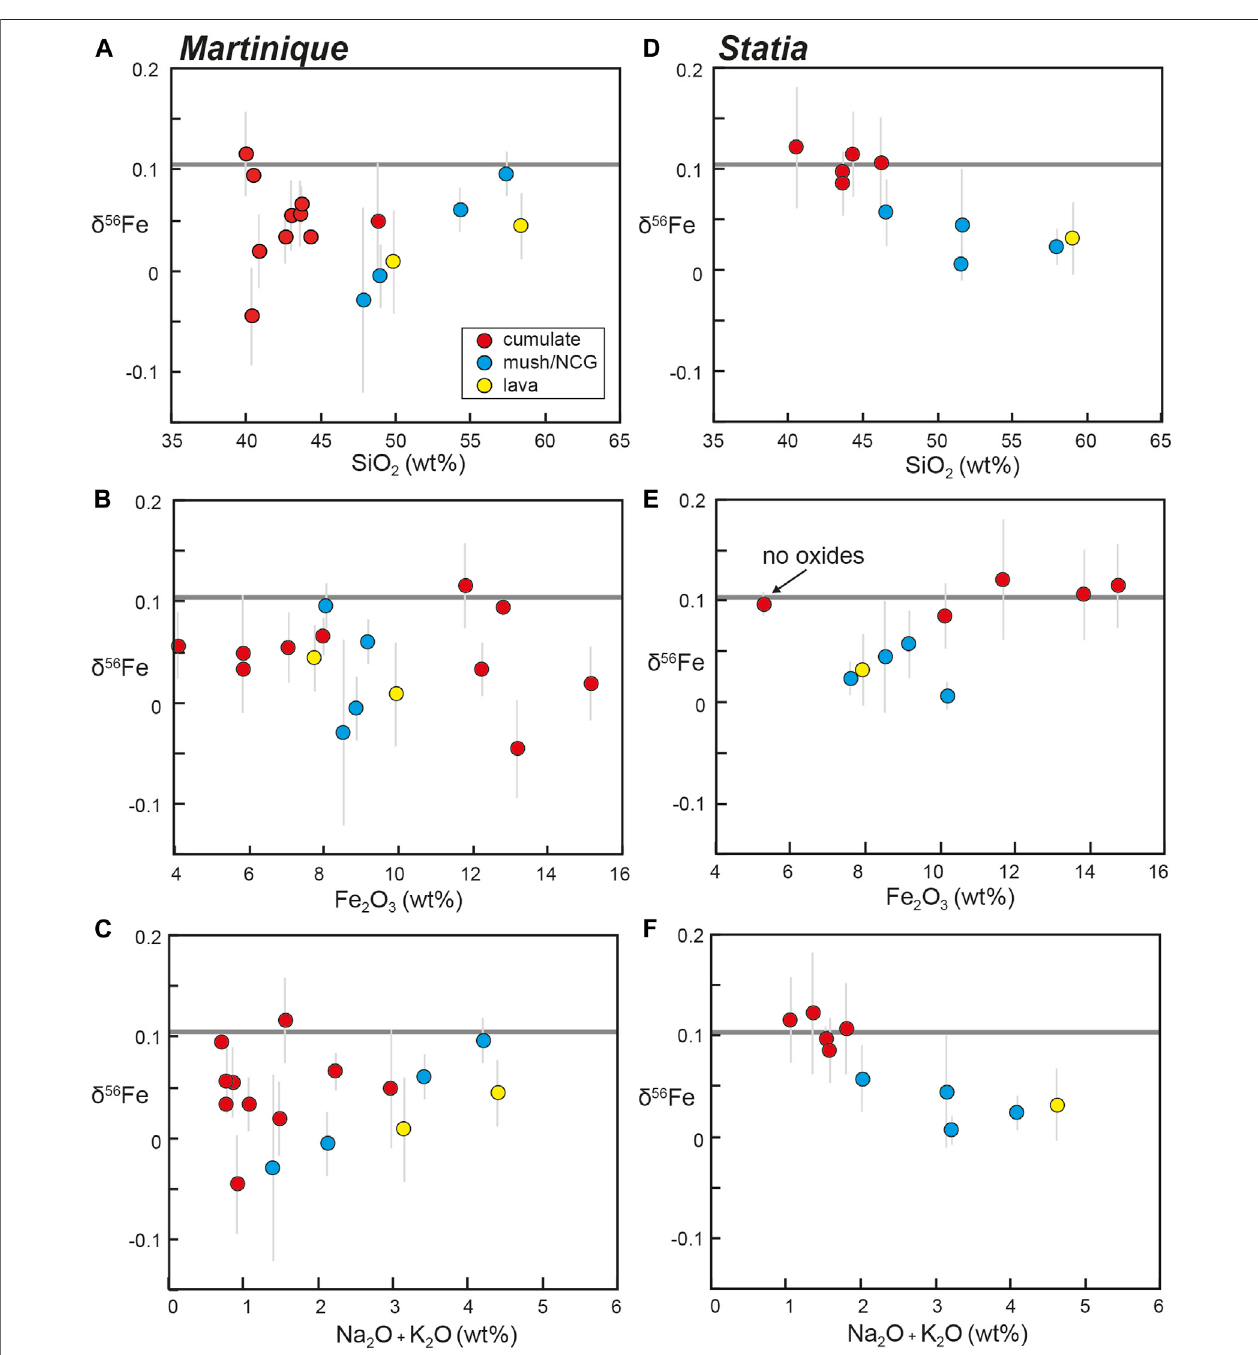
FIGURE 4 | Measured δ 56 Fe values versus major elements of cumulates (red circles), NCG ’ s (blue circles) and lavas (yellow circles) from Martinique (A – C) and Statia (D – F) .